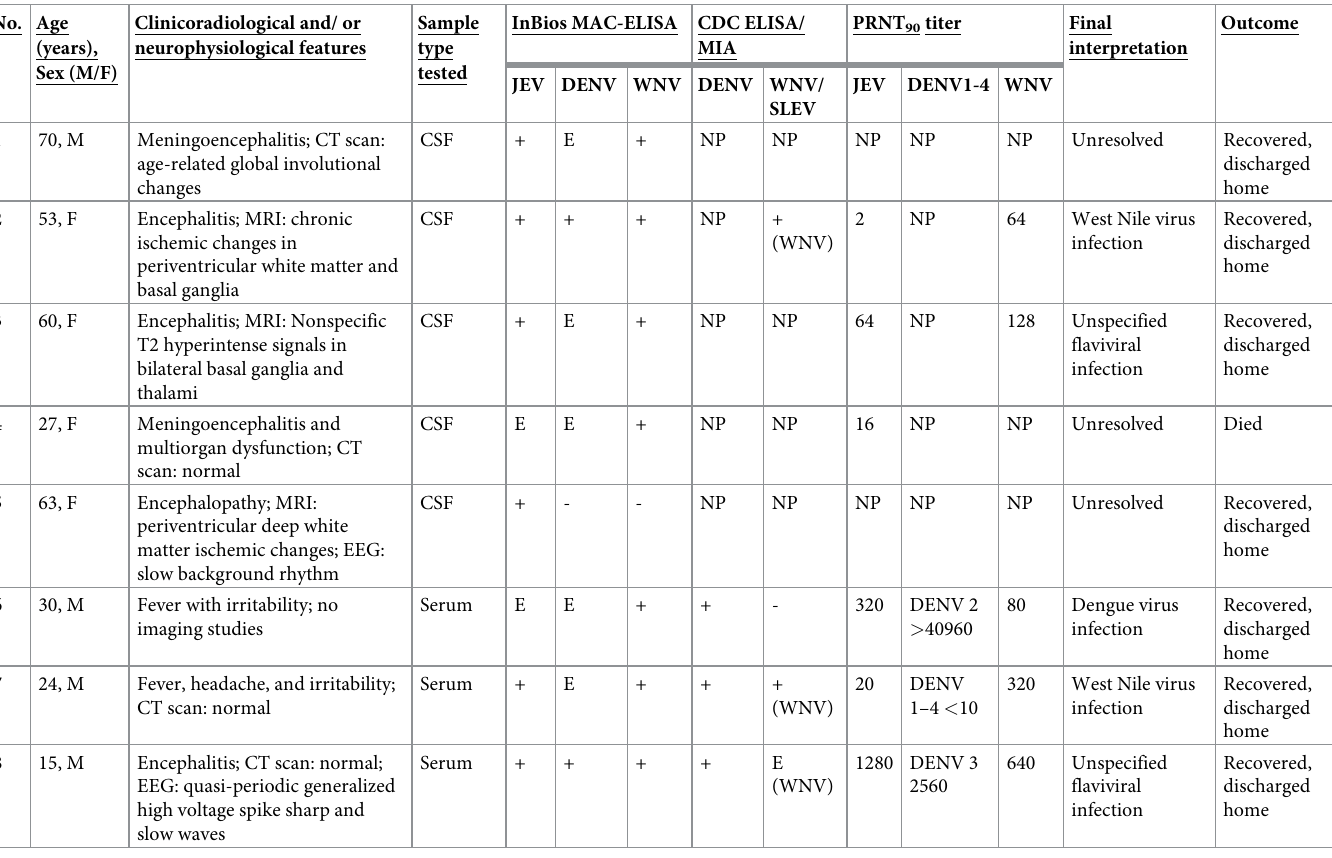
Fever with irritability; no imaging studies Fever, headache, and irritability; CT scan: normal Encephalitis; CT scan: normal; EEG: quasi-periodic generalized high voltage spike sharp and slow waves M = male; F = female; CSF = cerebrospinal fluid; PRNT 90 = Plaque reduction neutralization test with 90% endpoint; CT = computerized tomography; MRI = Magnetic Resonance Imaging; MAC-ELISA = IgM antibody capture enzyme linked immunosorbent assay; JEV = Japanese encephalitis virus; DENV 1–4 = Dengue virus serotypes 1–4; WNV = West Nile virus; SLEV = St. Louis encephalitis virus; (+) = Positive; (-) = Negative; NP = not performed; E = Equivocal; EEG =